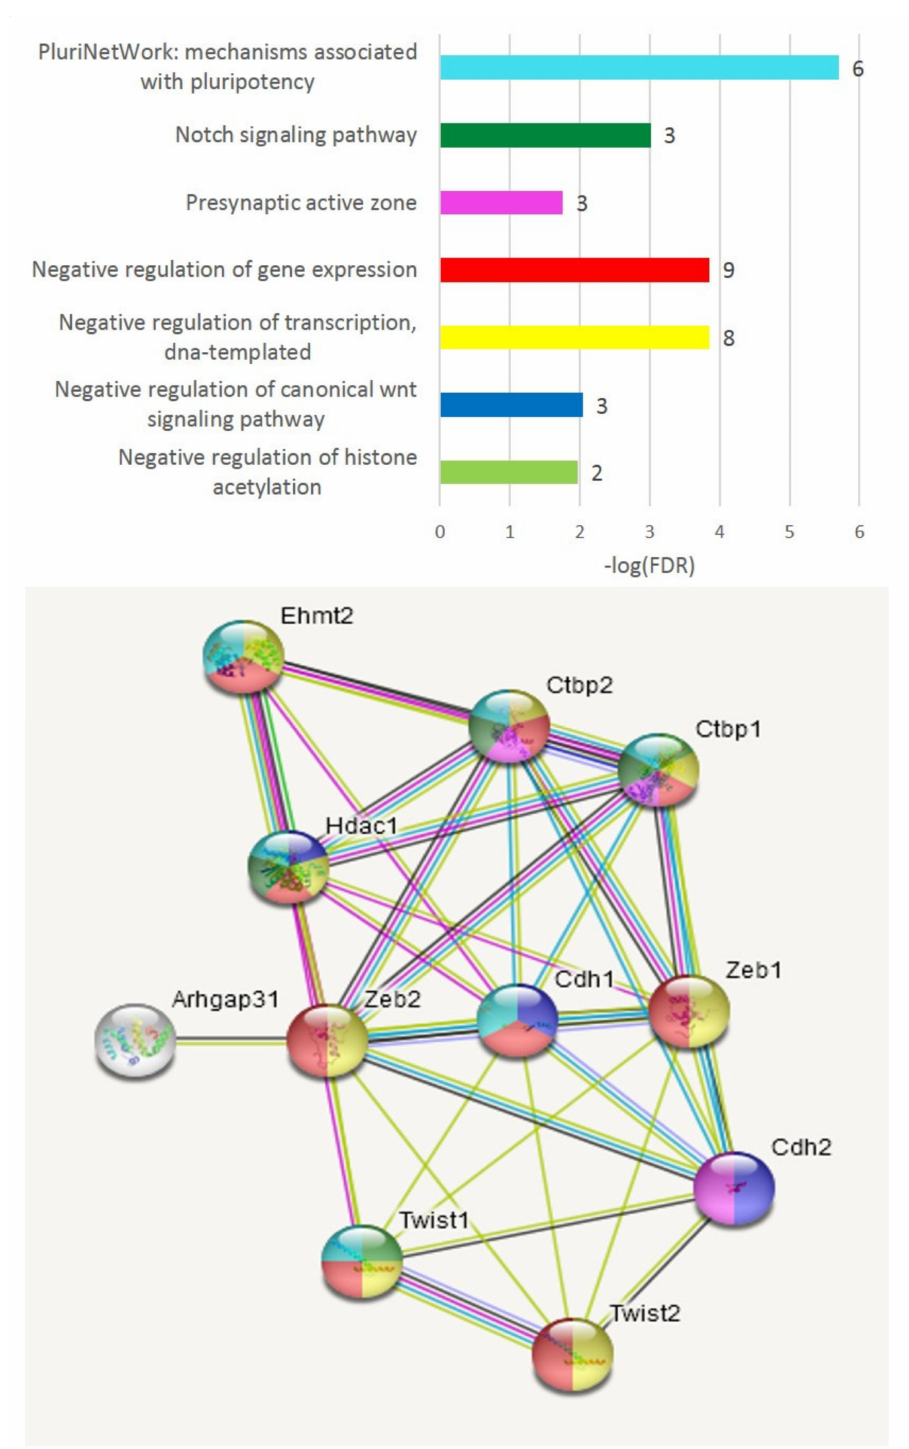
Figure 9. Neighborhood recovery of Zeb2 neighborhood inferred by string-db.org resource (11 genes) implies “repression of transcription” GO function of genes set. All but one ( Arhgap ) genes are transcriptional repressors; 8 genes belong to nucleus compartment (TFs); 4 genes ( Cdh1 , Cdh2 , Ctbp1 , Ctbp2 ) are associated with glutamatergic